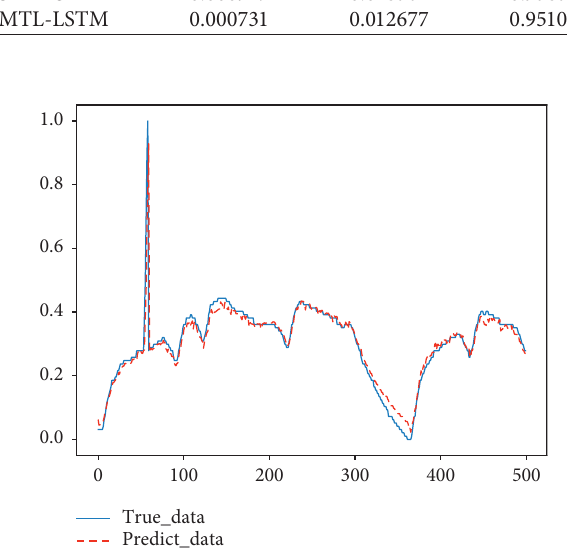
Figure 9: The comparison between the predicted value and true